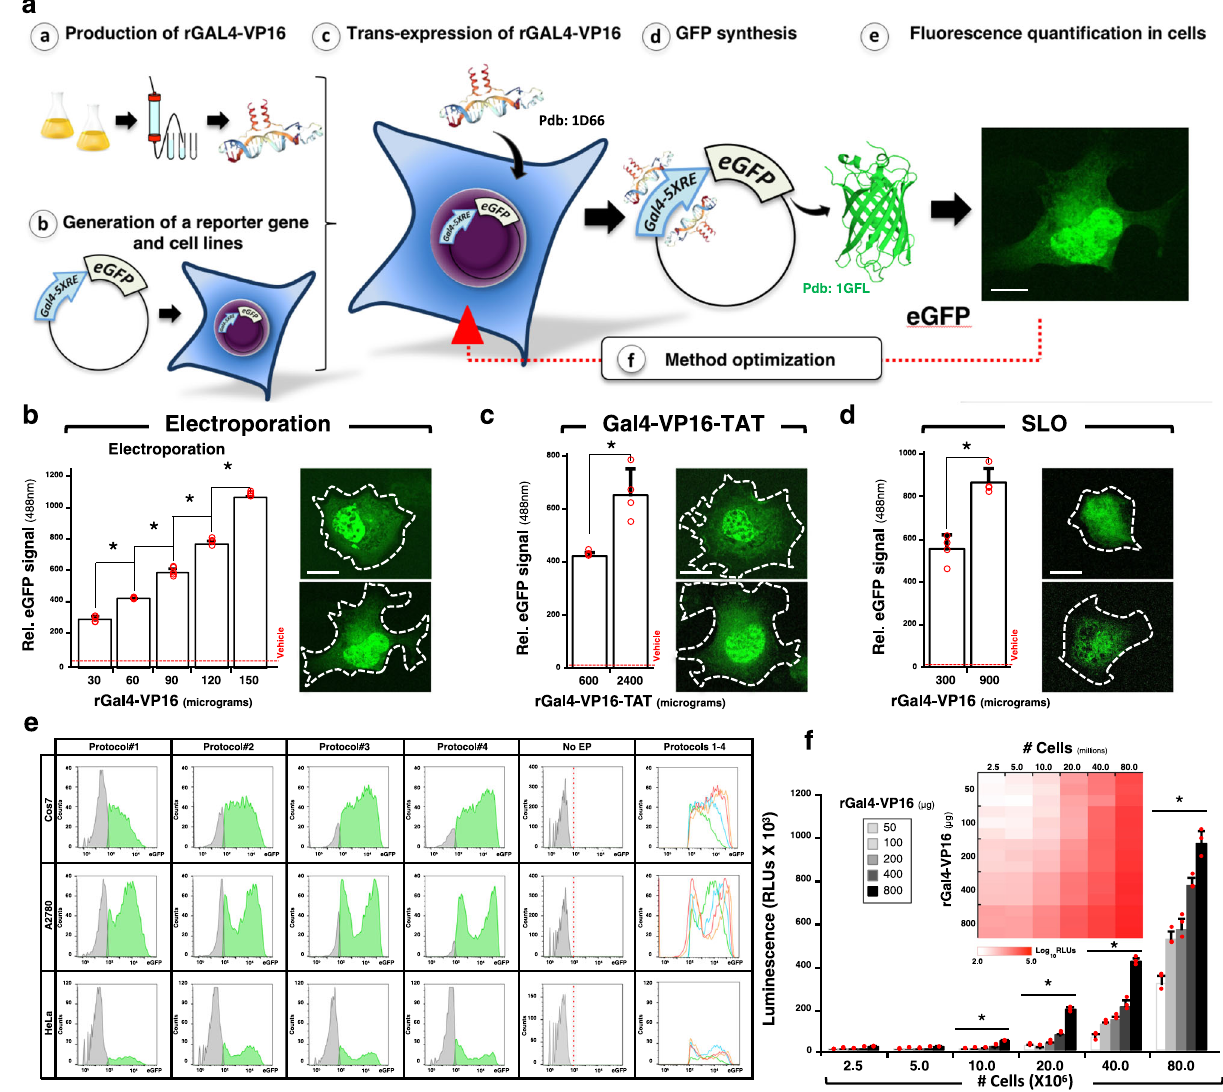
Fig. 1 A reporter system for “ transexpression ” . a Schematic representation of the reporter system based on recombinant Gal4-VP16 (rGal4-VP16)